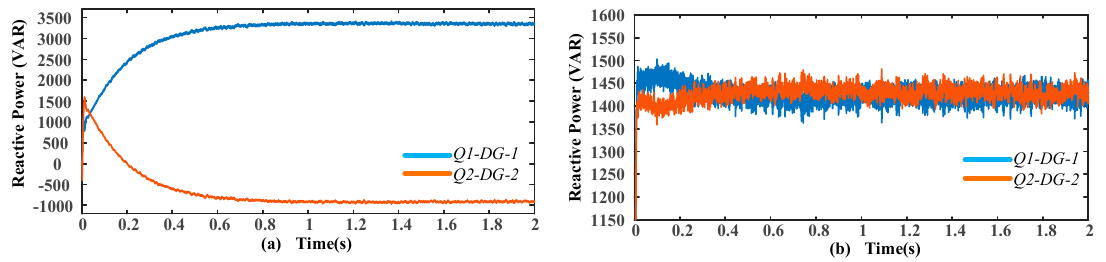
Figure 16. ( a ) Active power for the conventional control scheme; ( b ) active power for proposed control scheme.